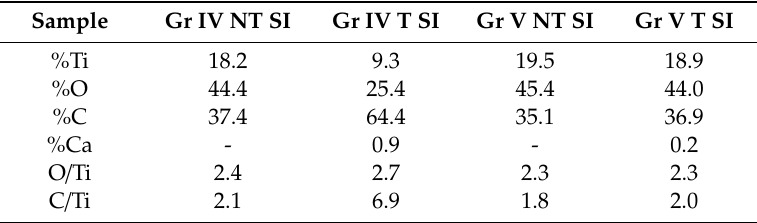
Table 3. Surface atomic percentages determined by XPS of the untreated grade IV, treated grade IV, untreated grade V and treated grade V with TiO 2 coating samples. (GR IV: Titanium grade IV; GR V: Titanium grade V; T: SLA treated; NT: SLA non-treated; SI: Treated with TiO 2 film).